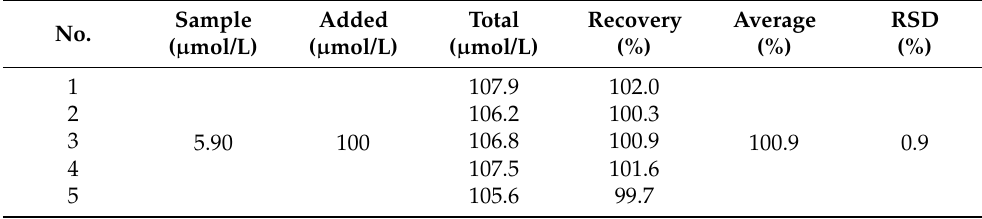
Table 4. MTX standard recovery ( n =